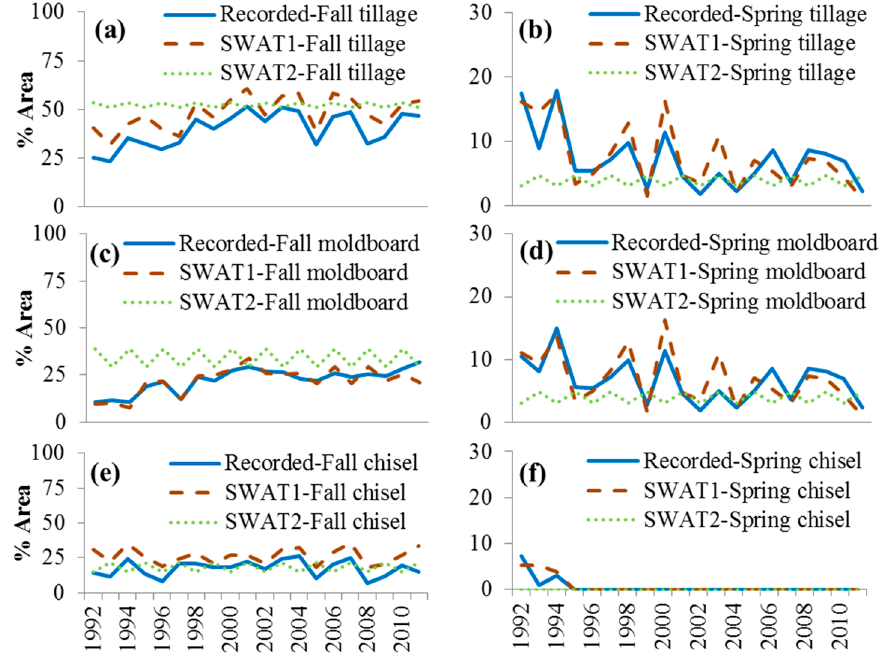
Figure 6. Input percentage areas of moldboard and chisel plowing in spring and fall and spring and fall tillage (moldboard + chisel) compared with records from 1992 to 2011 in the BBW. ( a ) Fall tillage, ( b ) spring tillage, ( c ) fall moldboard, ( d ) spring moldboard, ( e ) fall chisel, and ( f ) spring chisel.